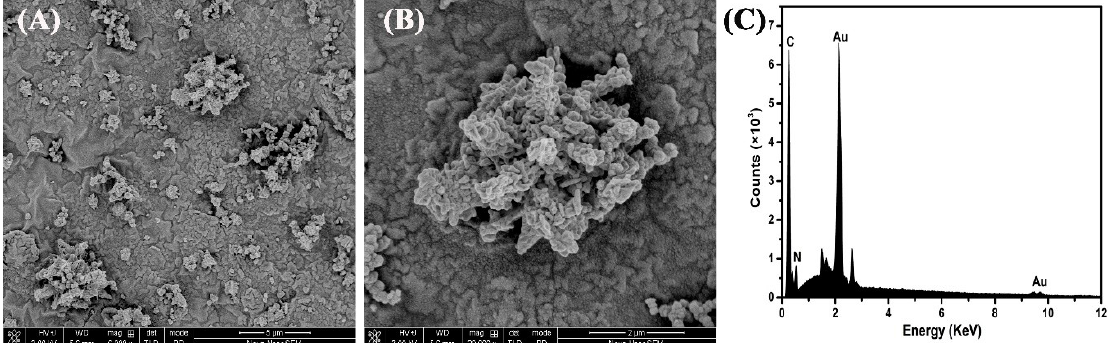
Figure 5. (A) SEM image of C 12 -PPy-Au composites and (B) the corresponding magnified SEM